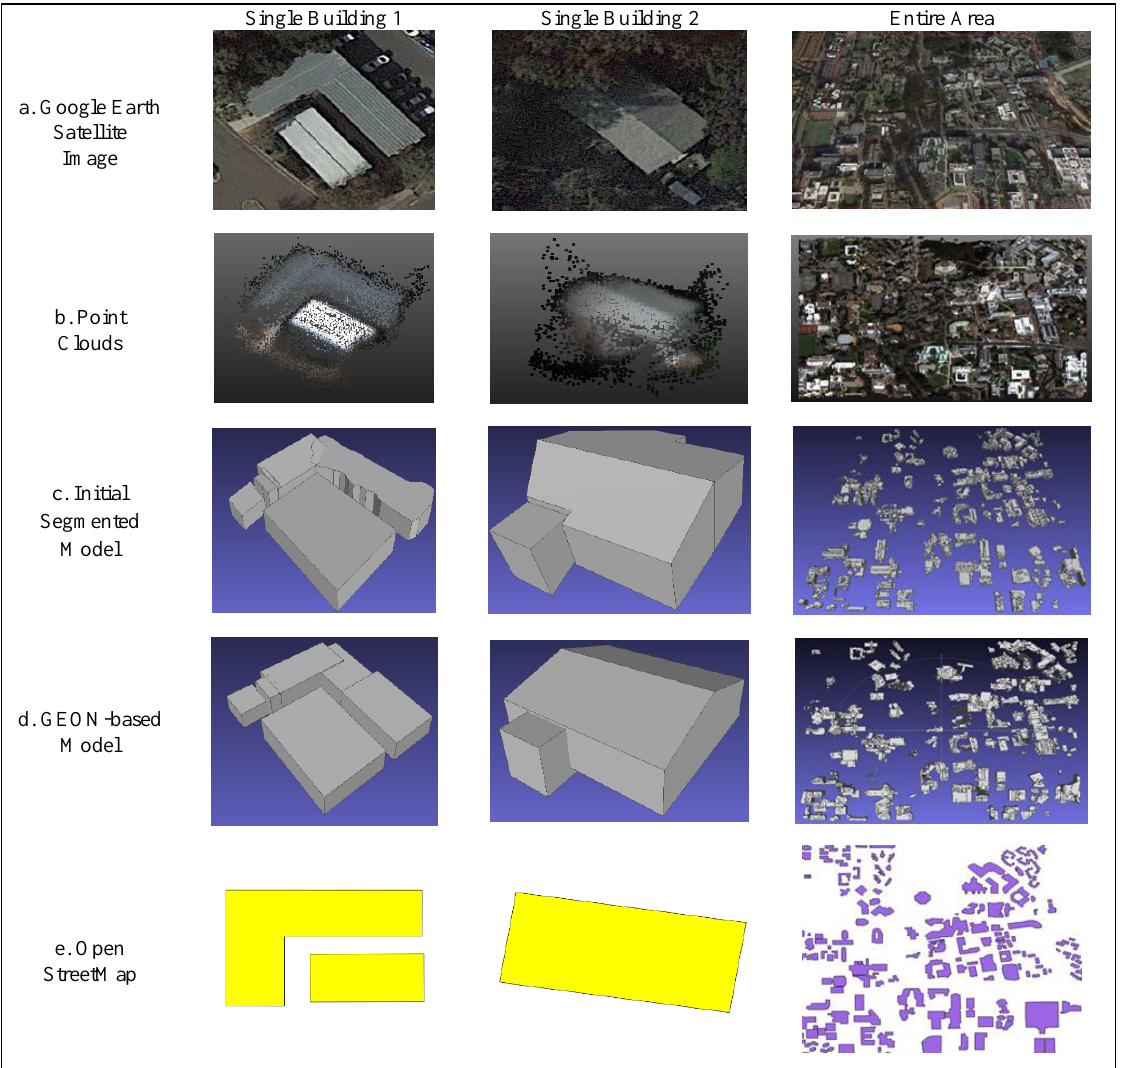
Fig 3. Sample building models from University of California at San Diego (from top to bottom: satellite image from Google Earth, point cloud, initial building surface, regularized and parameterized building models, OSM building